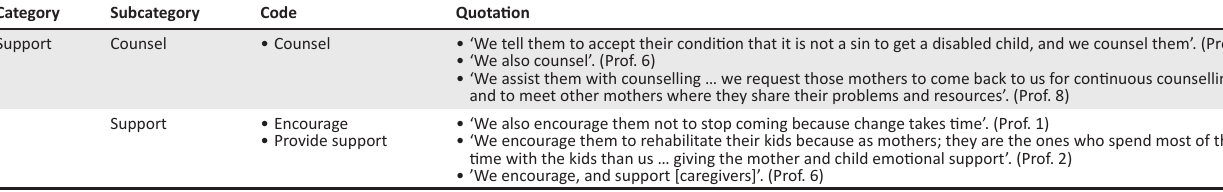
TABLE 3: Role of rehabilitation professionals: Support. Category